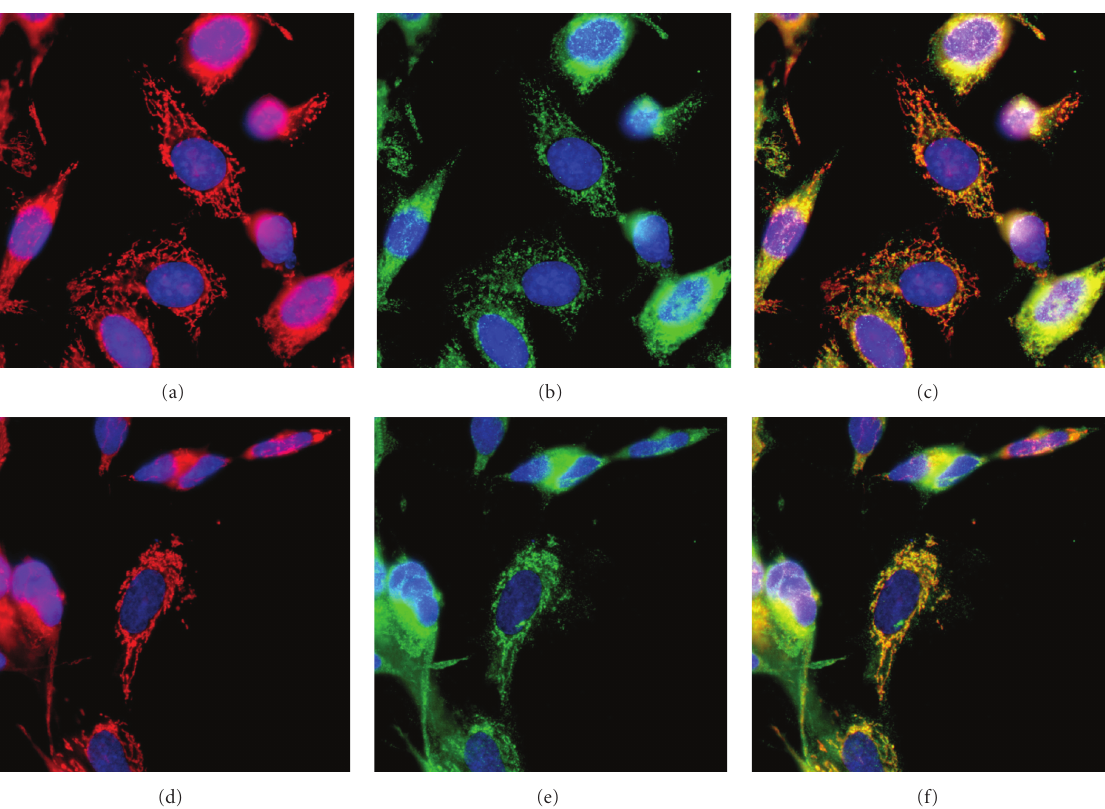
Figure 5: Cellular expression of TOM1L colocalize with the mitochondria. Confocal imaging of SK-N-SH neuroblastoma cells ((a)–(c)) or HeLa cells ((d)–(f)) stained with MitoTracker Red and antibodies against TOM1L. Individual images were separated digitally: ((a) and (d)) MitoTracker Red (red), ((b) and (e)) anti-TOM1L (green), and merged images ((c) and (f)). Cells were stained with DAPI (blue) to visualize the localization of the